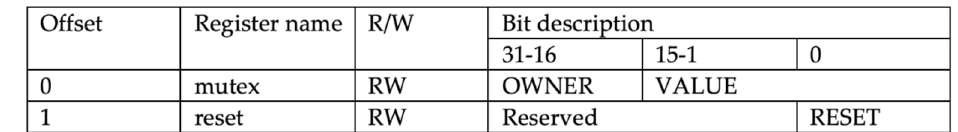
Table 5. On-Chip memory blocks on Stratix IV family.